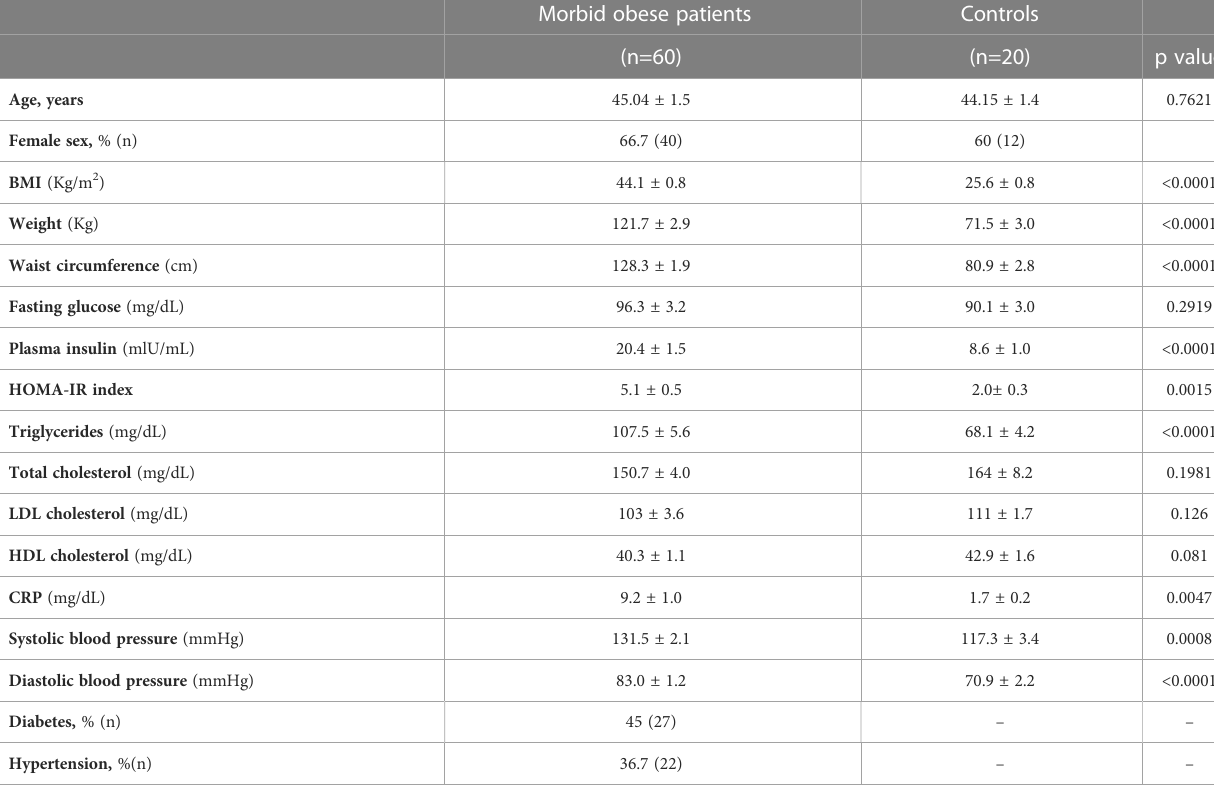
TABLE 1 Demographic and clinical parameters of morbidly obese patients and control